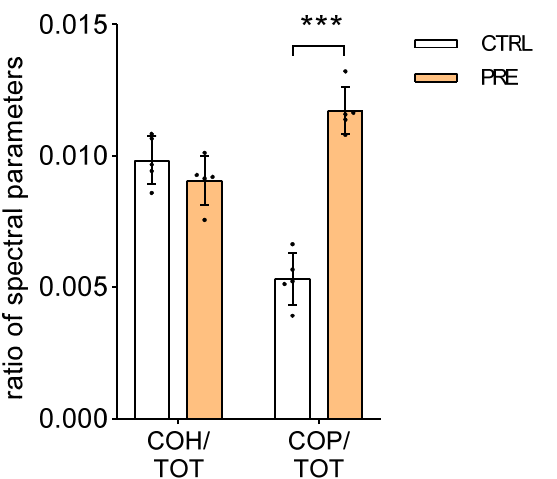
Figure 7. Analysis of relative amount of glycosylated (COH) and phosphorylated (COP) compounds in CV by means of FTIRI. Bars represent the ratio between the following spectral parameters: COH/TOT an COP/TOT. Results are reported as mean ± SD of five independent samples ( n = 5) and asterisks indicate significant differences between CTRL and PRE groups (*** = p < 0.001).